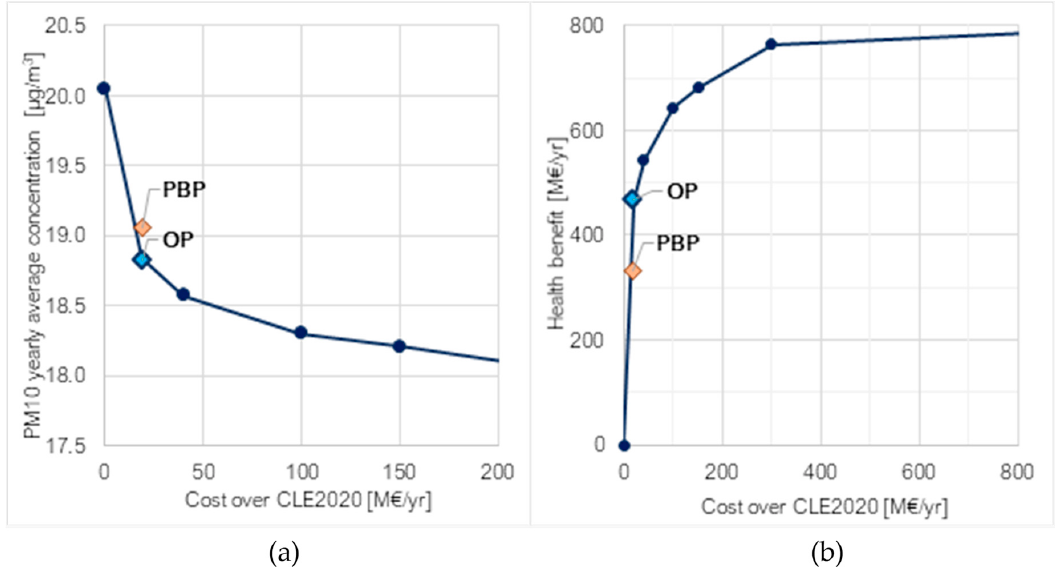
Figure 5. ( a ) PBP and optimal policy (OP) in the objective space, on the horizontal axes the cost over